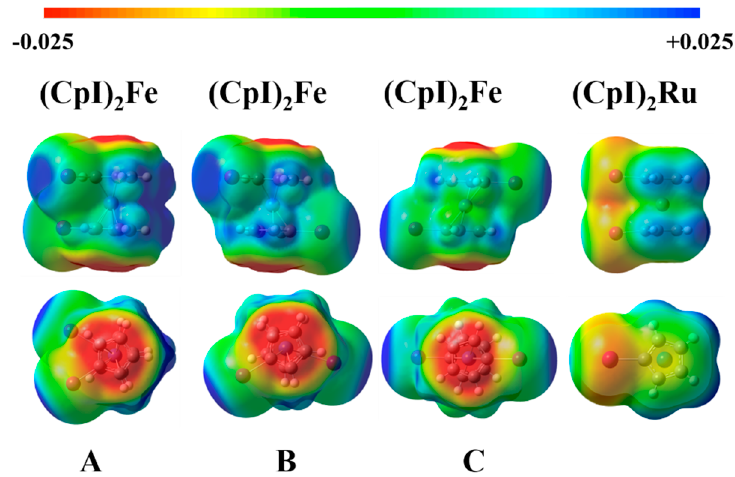
Figure 2. Electrostatic potential mapped onto an electron density isosurface for three isomers of (CpI) 2 Fe and for (CpI) 2 Ru (side and top views). The isomers present, respectibly, angles of 60, 123 and 180° between the C-I bonds.